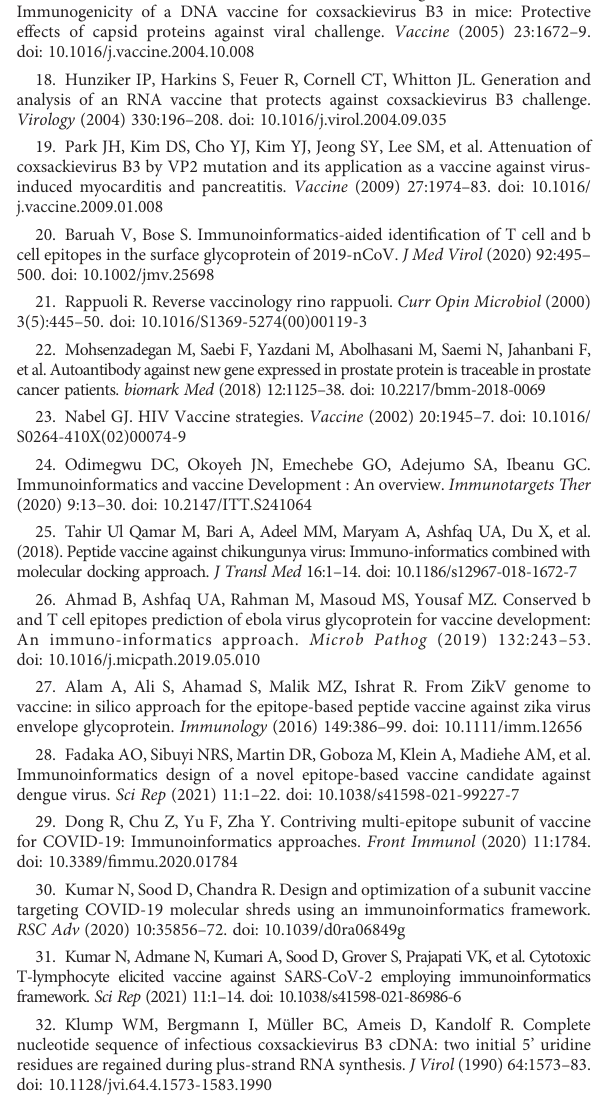
FIGURE S1 The multiple sequence alignment between different serotypes of CVB, the epitopeselectedforvaccineconstructhavebeenidenti fi edbyblackboxes. (A) Multiple sequence alignment of VP1 protein sequences. (B) Multiple sequence alignment of VP2 protein sequences. (C) Multiple sequence alignment of VP3 protein sequences. (D) Multiple sequence alignment of 2A protein sequences. (E) Multiple sequence alignment of 2C protein sequences. (F) Multiple sequence alignment of 3C protein sequences. FIGURE S2 The analysis of the sequence homology of the CVB vaccine construct. FIGURE S3 The original 3D structure model of the CVB vaccine prediction by the AlphaFold2 program.